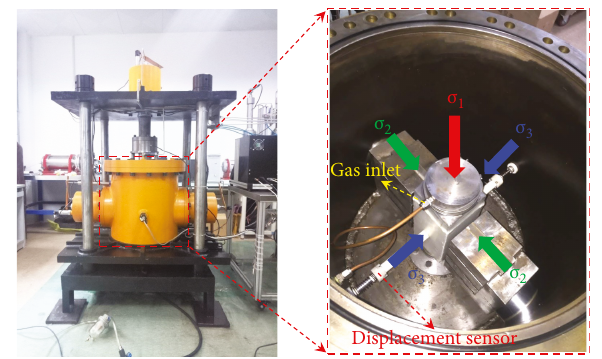
Figure 3: Interior structure of the true triaxial pressure cell.